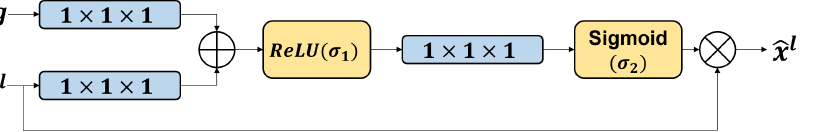
Figure 7. Additive attention gate (AG) of UNet. The separate 1 × 1 × 1 convolutions are used for the input features ( x l ) and the gating signal. Following that, the features are added and subjected to several linear transformations, including ReLU activation ( σ 1 ), 1 × 1 × 1 convolution, and sigmoid activation ( σ 2